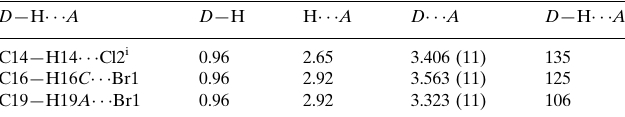
Hydrogen-bond geometry (A˚ , (cid:2)